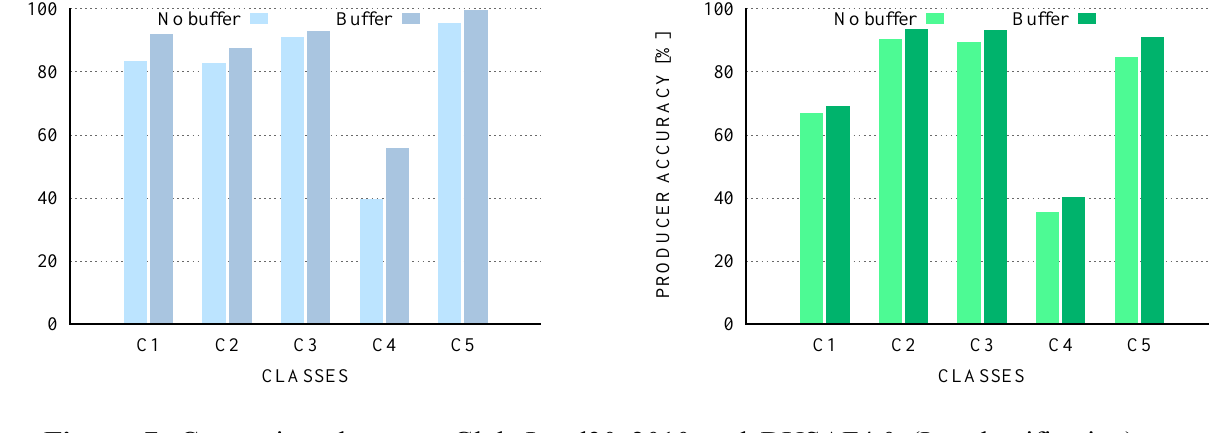
Figure 7. Comparison between GlobeLand30 2010 and DUSAF4.0 (I reclassification): per-class statistics referred to 30 m resolution input datasets. C1: artificial surfaces, C2: agricultural areas, C3: forest and semi natural areas, C4: wetlands, C5: water bodies. Table 9. Comparison between GlobeLand30 2010 and DUSAF4.0 (I reclassification): per-classes values of confidence interval at 95% probability calculated for user (UA) and producer accuracies (PA); data refer to 30 m resolution input datasets.